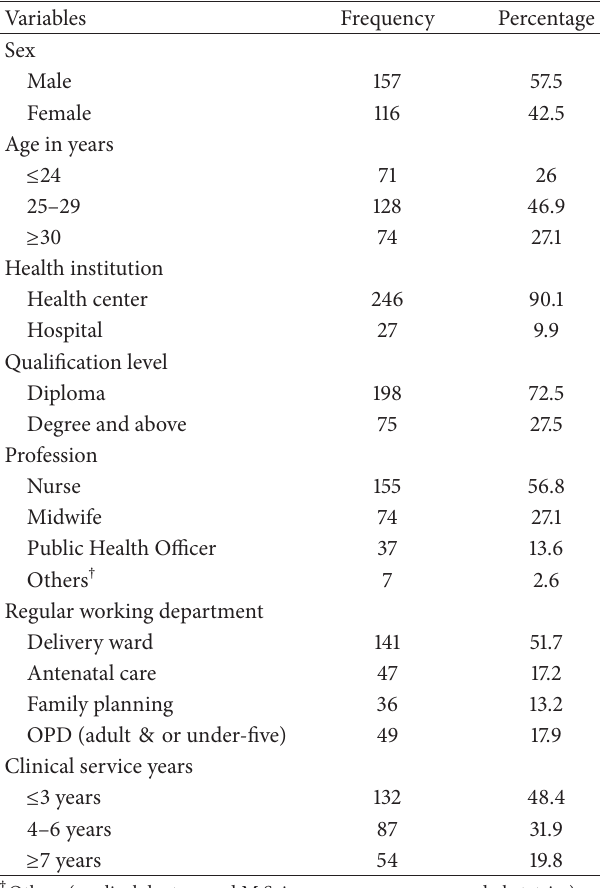
Table 3: Characteristics of obstetric caregivers and public health